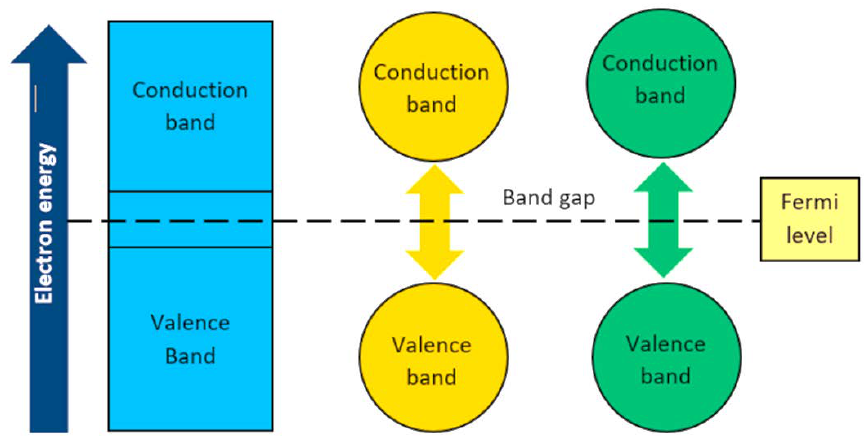
Figure 1. The difference between the band structures of conductors (metals), semiconductors, and insulators.